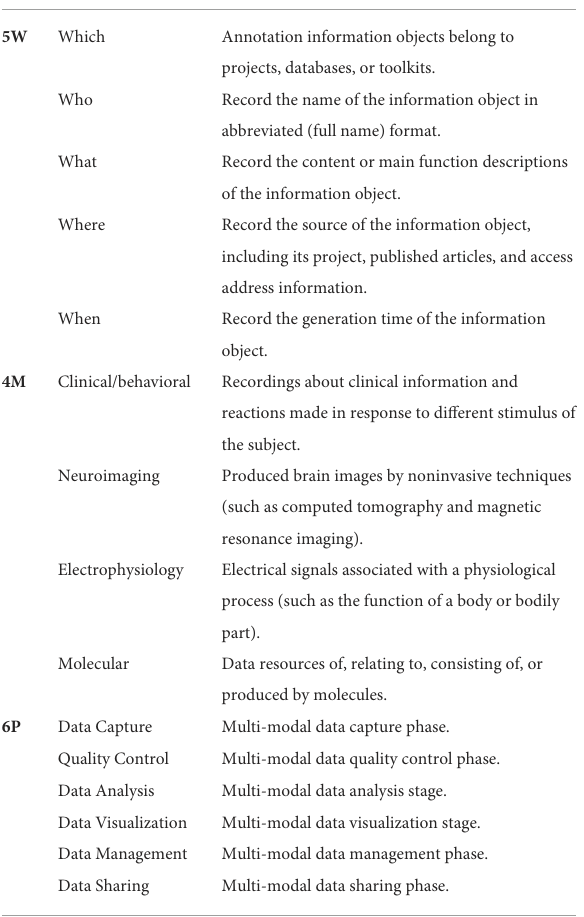
TABLE 2 A summary and collation framework for projects, databases, and